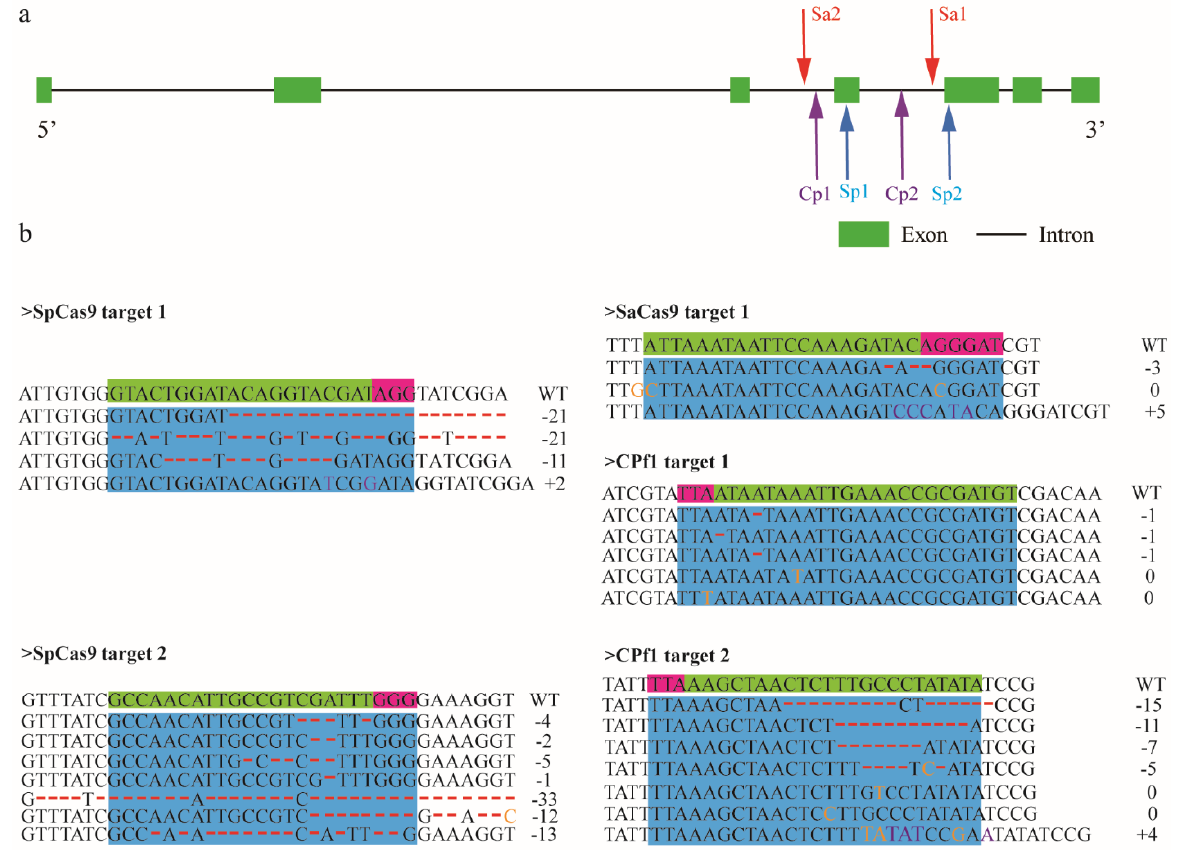
Figure 4. Gene mutation mediated by SpCas9, SaCas9, and Cpf1 in A. mellifera embryos: ( a ) schematic diagram of gene structure and target sites position on Amyellow-y gene. The green rectangle and black line represent exons and introns, respectively. The sgRNA site position is indicated by chromatic arrows. Sa1 and Sa2 represent target 1 and target 2 of SaCas9, respectively. Cp1 and Cp2 indicate target 1 and target 2 of Cpf1, respectively. Target 1 and target 2 of SpCas9 are presented as Sp1 and Sp2, respectively; ( b ) Amyellow-y mutation patterns induced by different CRISPR systems. The left panel indicates mutation patterns introduced by Spcas9. The top figure of the right panel represents mutation patterns mediated by Sacas9. The middle figure and the bottom figure of the right panel indicate mutation patterns induced by Cpf1. PAM motif and targetable site are presented as letters in pink and light green boxes, respectively. The insertion events are lettered in purple, the substituted bases were denoted by orange letters, and the base deletion is represented by red dashed lines. The spacer sequence and PAM motif are highlighted in blue colour. The black number labelled at the right of each mutation sequence represents altered nucleotide length (−, deletion; +, insertion; 0, substitution). WT indicates the honeybee embryos injected with purified water.